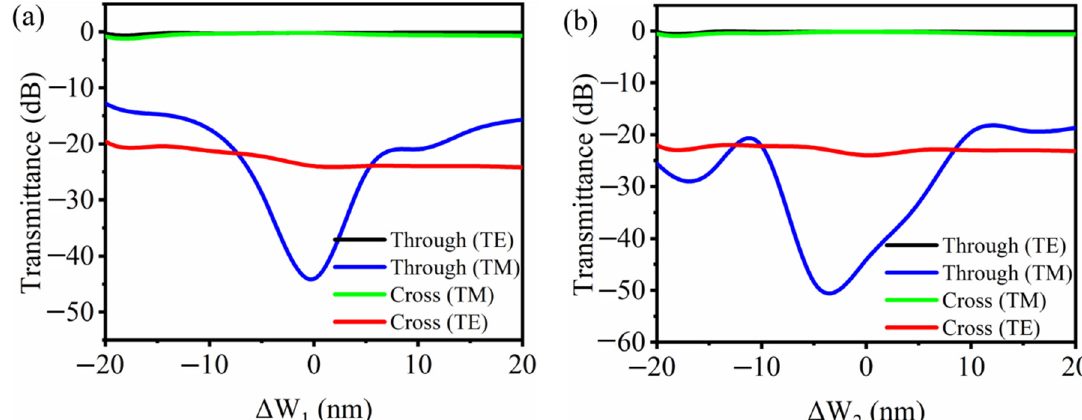
Figure 6. Simulated transmission spectra for both polarizations with the change of waveguide widths ( a ) Δ W 1 and ( b ) Δ W 2 .